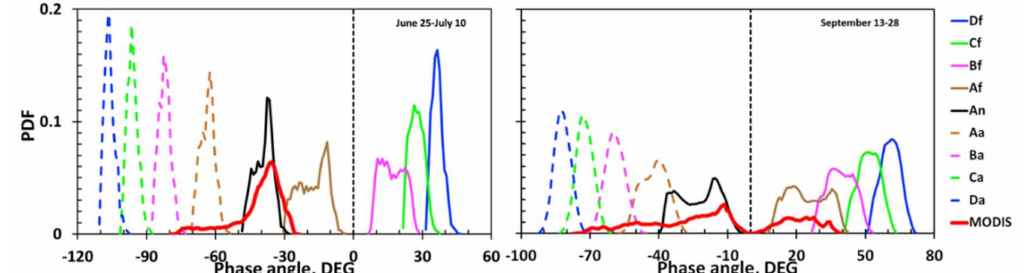
Figure 12. Probability density function (PDF) of the phase angle during 25 June to 10 July and 13–28 September periods over Amazonian rainforests (0 ◦ to 10 ◦ S and 60 ◦ W to 70 ◦ W) for Terra MODIS and MISR Sun-sensor geometries derived from MODIS and MISR data for the period from June 2000 to May 2008. MISR views the Earth’s surface symmetrically about the nadir in the forward and backward directions along the spacecraft’s flight track with nominal view zenith angles relative to the surface reference ellipsoid of 0.0 ◦ (camera An), 26.1 ◦ (Af and Aa), 46.5 ◦ (Bf and Ba), 60.0 ◦ (Cf and Ca) and 70.5 ◦ (Df and Da). MODIS is a single view sensor that scans the Earth’s surface across the spacecraft flight